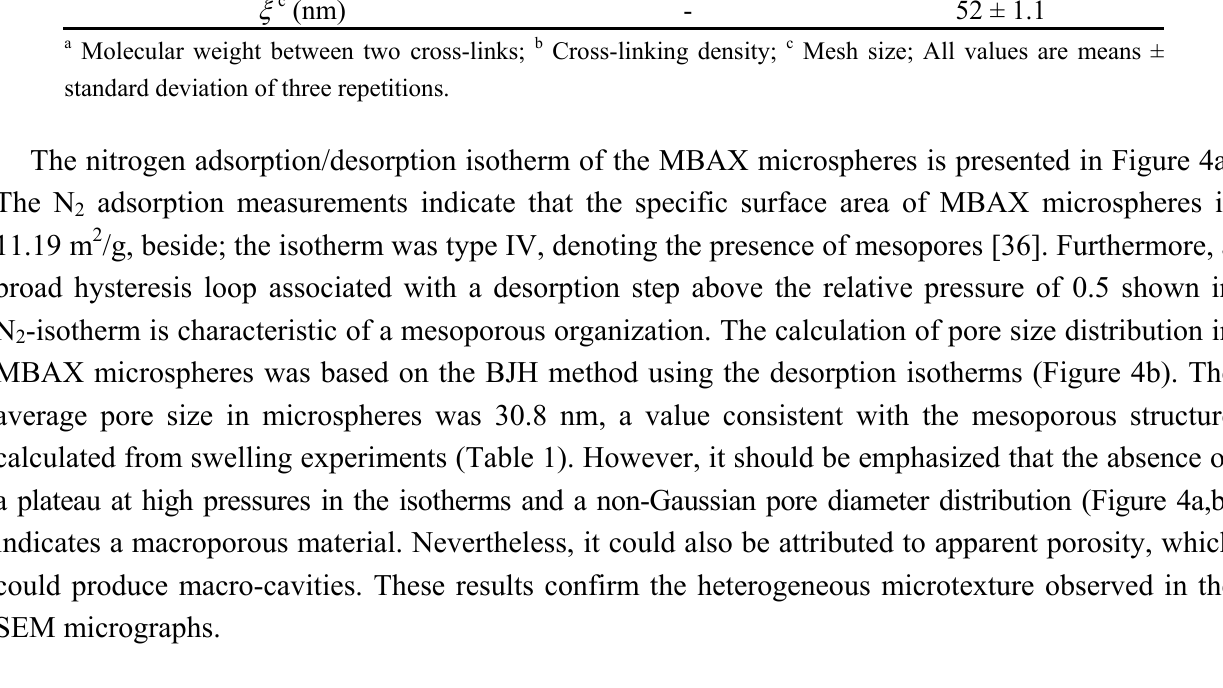
Figure 4. Textural analysis of MBAX microspheres. ( a ) Isotherm; ( b ) Pore size